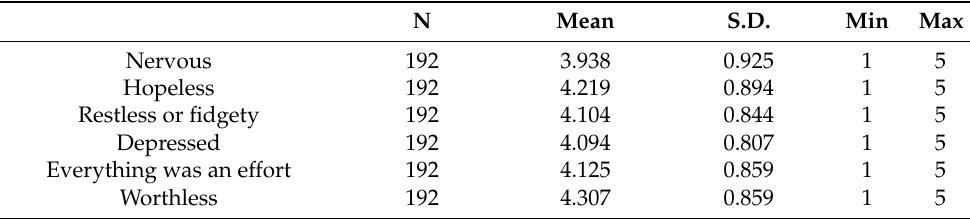
Table 2. Summary statistics of K6 results related to feelings.